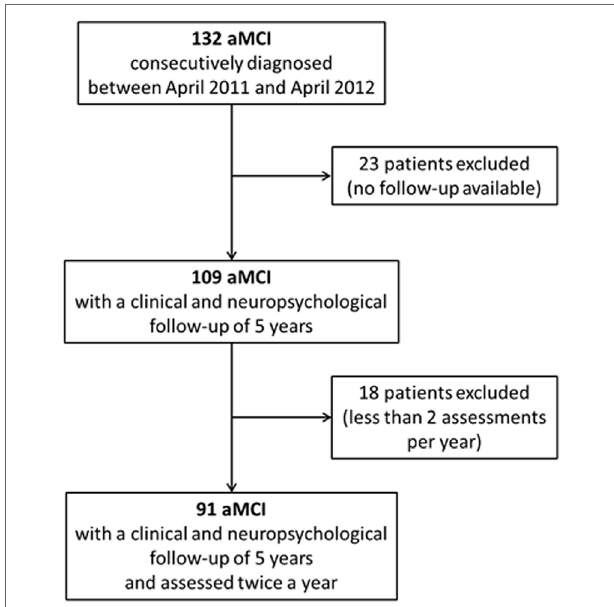
FigUre 1 | Flow chart of the study. One hundred thirty-two amnesic MCI (aMCI) patients were initially enrolled. Forty-one participants were retrospectively excluded (23 resulted were lost to follow-up; 18 did not undergo two or more clinical and neuropsychological assessments per year). Data from 91 aMCI subjects were finally considered for the present analyses.